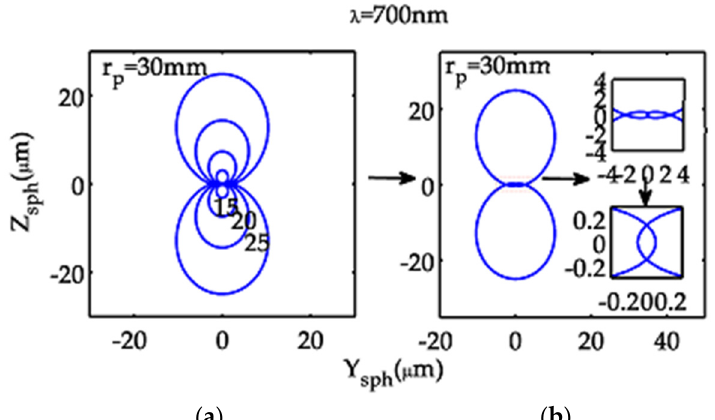
Figure 2. Spherical aberration curves for λ = 700 nm of the model optical system in the meridional focal plane: ( a ) with r p = 30, 25, 20, 15 mm and ( b ) with r p = 30 mm (each inset is an enlargement of a central portion of the curve).